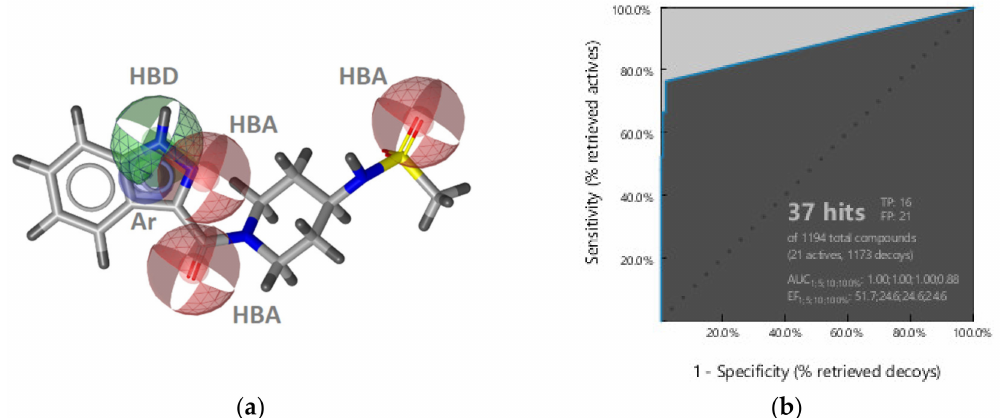
Figure 13. ( a ) LB-TopoII-Model-5 , a consensus model derived from four selective TopoII inhibitor ligand-based pharma- cophore models. The pharmacophore features include aromatic (blue disc), hydrogen bond donor (HBD, green arrow), and hydrogen bond acceptor (HBA, red sphere). ( b ) ROC plot (curve shown in blue) from virtually screening 1194 compounds (21 TopoII actives and 1173 decoys) with LB-TopoII-Model-5 . TP = true positives; FP = false positives; AUC = area under the curve; EF = enrichment factor.